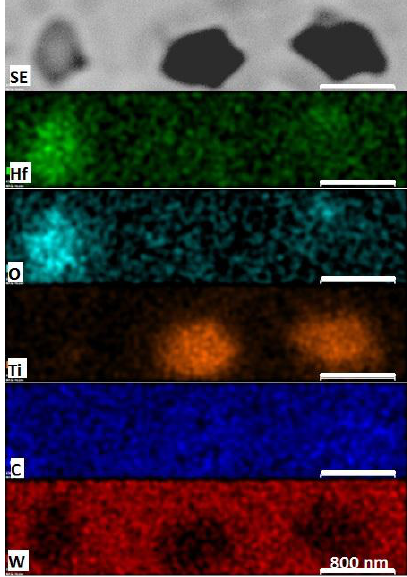
Figure 3. EDS map of area in W-3Ti-2HfC sample containing dispersed particles. All the scale bars represent the same size of 800 nm.